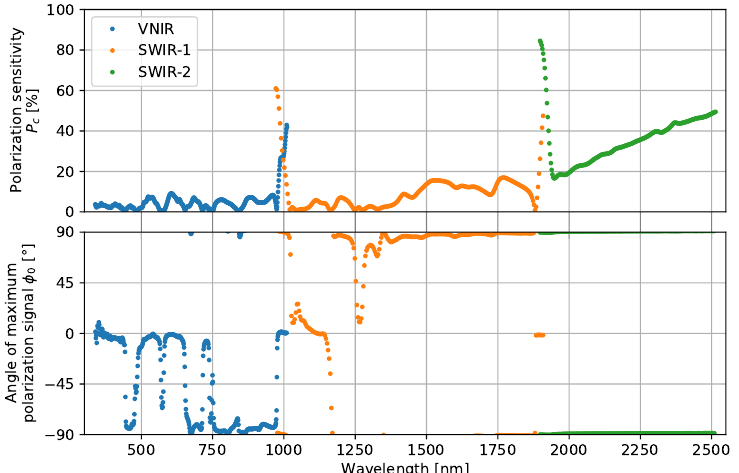
Figure 10. ( top ) Polarization sensitivity of the SVC HR-1024i spectroradiometer. ( bottom ) Angle of polarization with respect to the slit direction of the spectroradiometer where its signal is